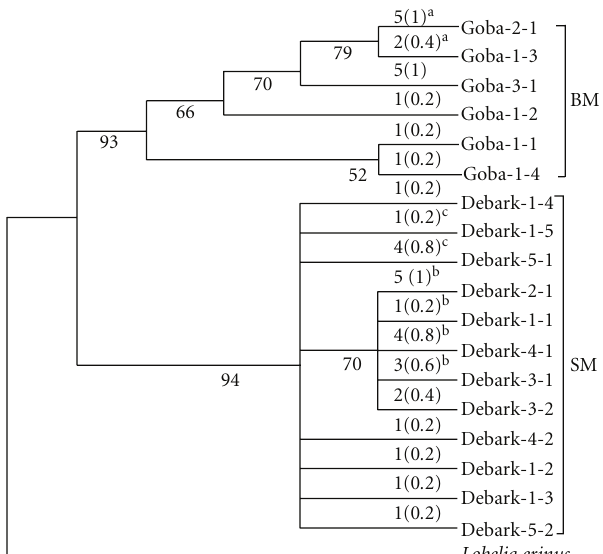
Figure 2: The bootstrap 50% majority rule consensus tree of 18 haplotypes from the ten L. rhynchopetalum populations. Bootstrap values greater than 50 are given below the branches. The frequency and relative frequency of each haplotype in each population are given above the branches outside and inside parenthesis, respectively. Haplotypes shared by more than one population are indicated with the same